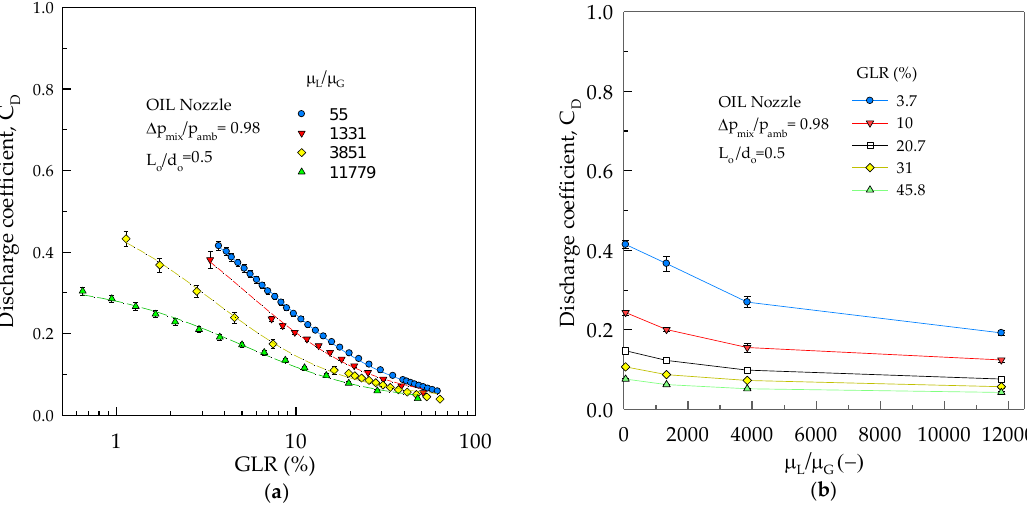
Figure 7. The effect of ( a ) GLR on C D at different µ L /µ G and of ( b ) µ L /µ G on C D at different GLRs.